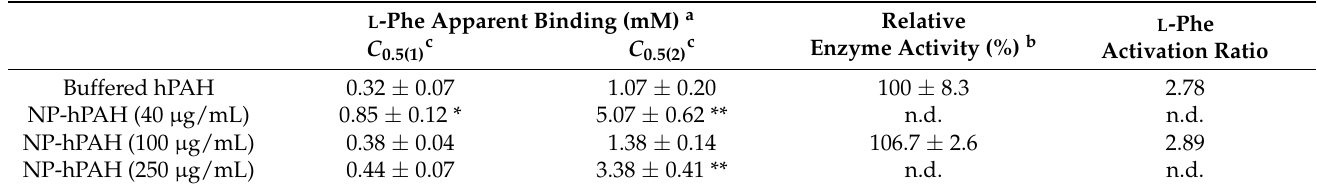
Table 1. Catalytic activity, L -Phe activation ratio and L -Phe apparent binding ( C 0.5 ) of human phenylalanine hydroxylase (hPAH) encapsulated in nanoparticles (NP) at different concentrations. L -Phe Apparent Binding (mM) a Relative Enzyme Activity (%) b Buffered